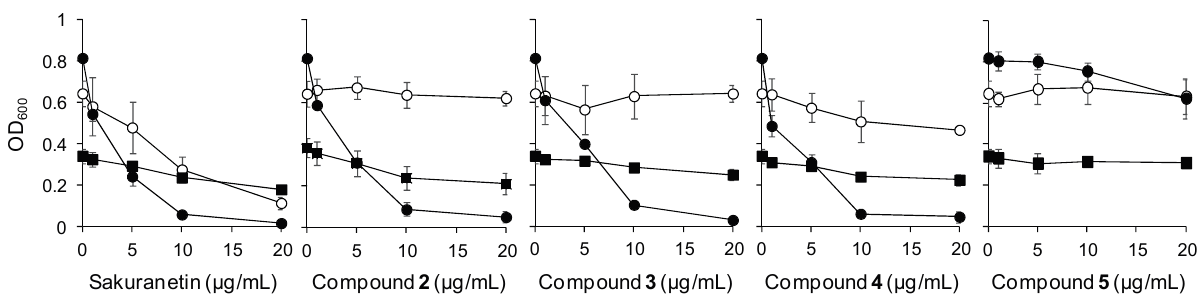
Figure 4. Antibacterial activity of the UV-induced phenolic compounds to bacterial pathogens, Xoo ( ■ ), Xoc ( ● ), B. glumae ( ○